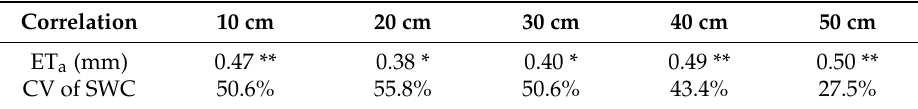
Table 6. Correlation between ET a and SWC of each layer for